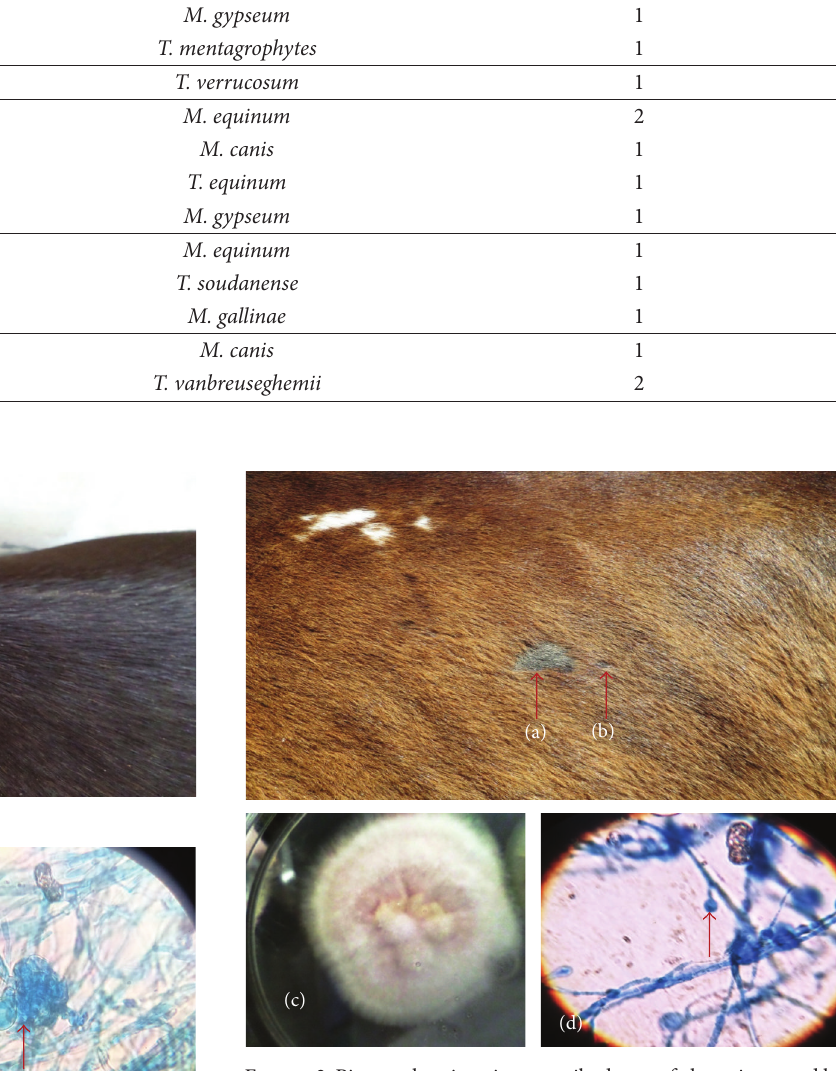
Figure 2: Picture showing circumscribed area of alopecia caused by M. gallinae on the flank of a horse (a), a satellite lesion (b), pink to cream tinged colony of M. gallinae (c), and pyriform microconidia of M. gallinae (d) (LCB ×